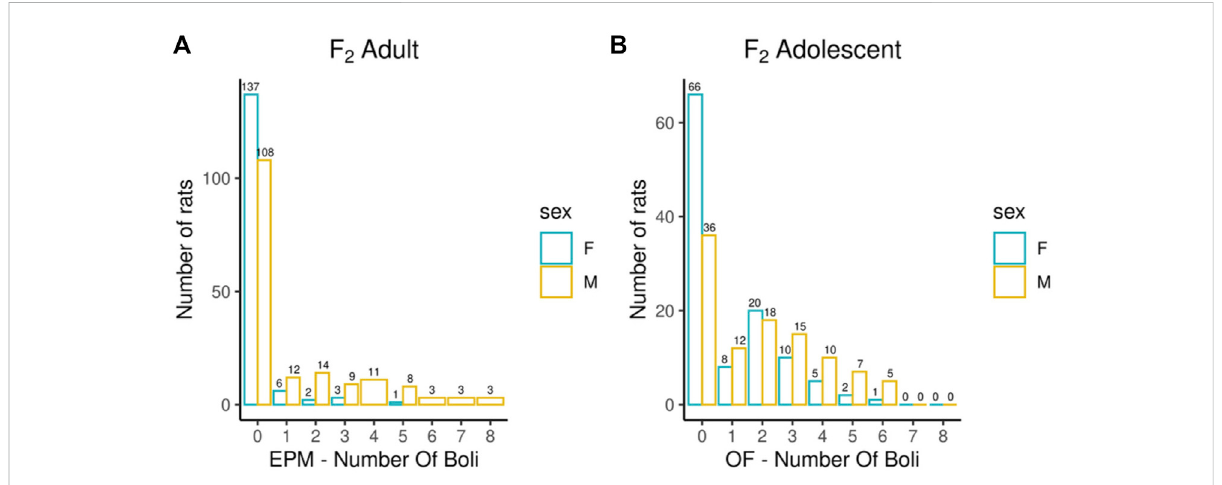
FIGURE 2 NumberoffecalbolicountsduringEPMandOFexperiments.Barchartdepicting thenumberoffecalbolicountscoloredbysexduringEPM (A) and OF experiments (B) . Summary statistics for the trait data are reported in Supplementary Table